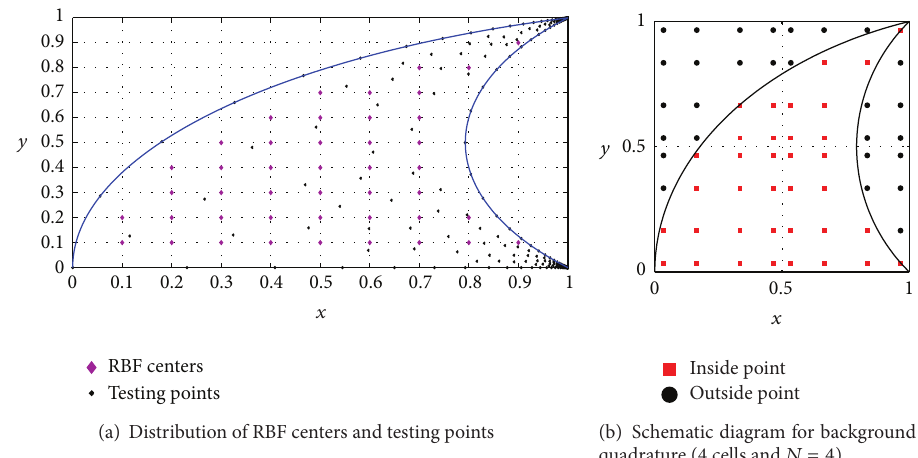
Figure 6: The distribution of RBF points and quadrature points in background mesh.